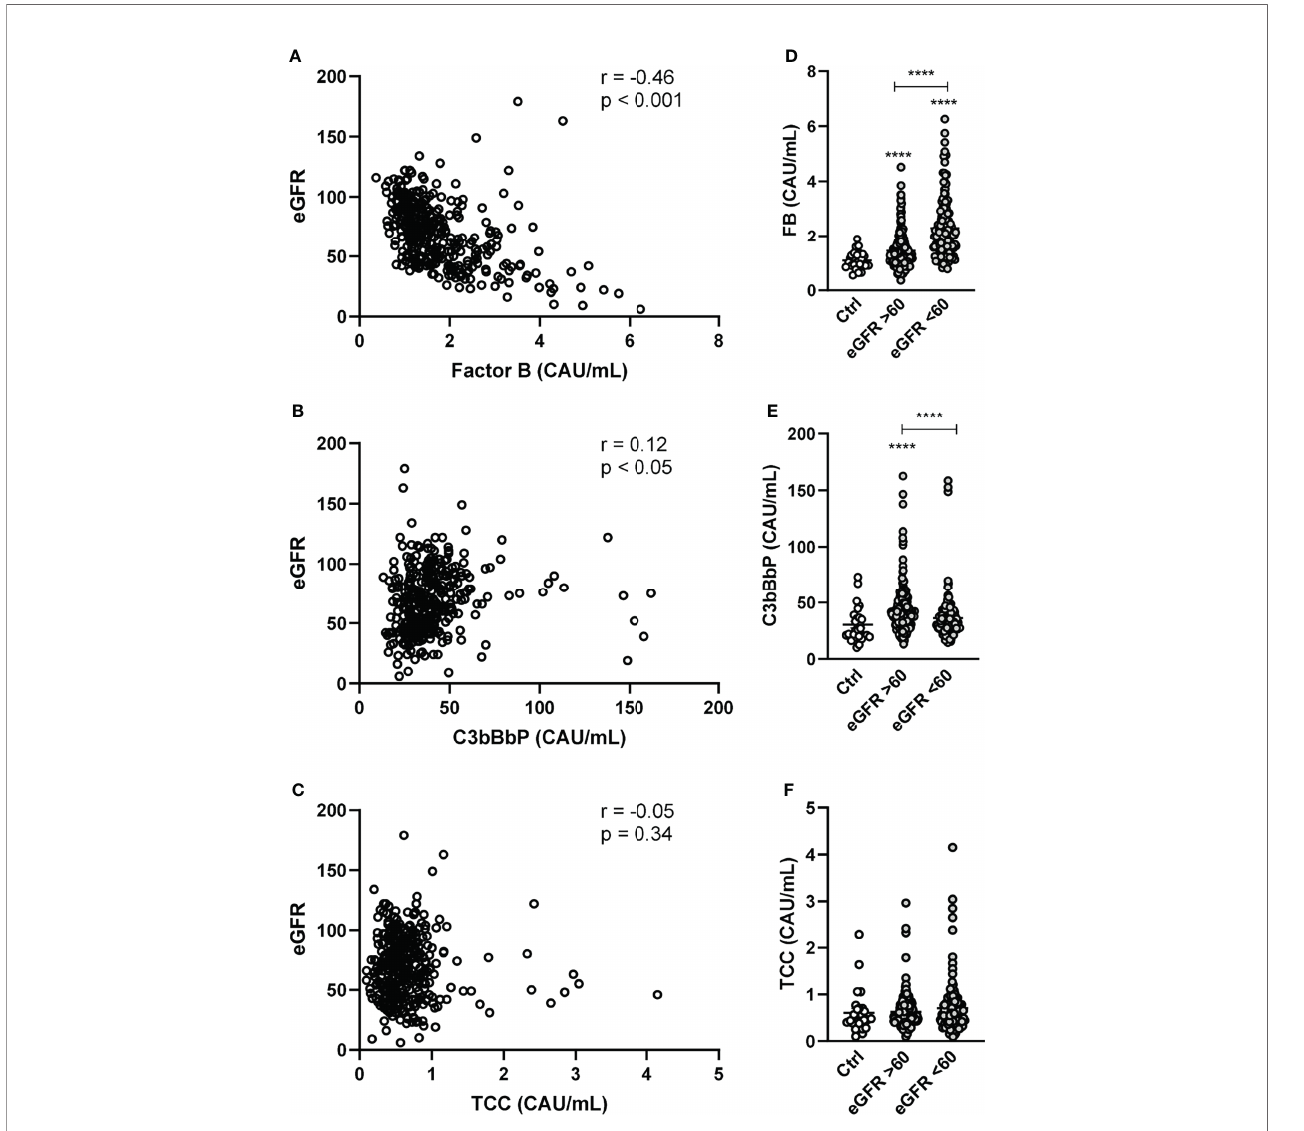
FIGURE 2 | Factor B and C3bBbP are partly associated with impaired kidney function. Correlation between estimated glomerular fi ltration rate (eGRF) and plasma levels of (A) factor B (FB) (B) C3bBbP and (C) TCC. Levels of (D) FB, (E) C3bBbP and (F) TCC in healthy controls and in HF patients with normal (i.e. eGFR>60) or deteriorated (i.e. eGFR<60) kidney function. Values are mean±SEM